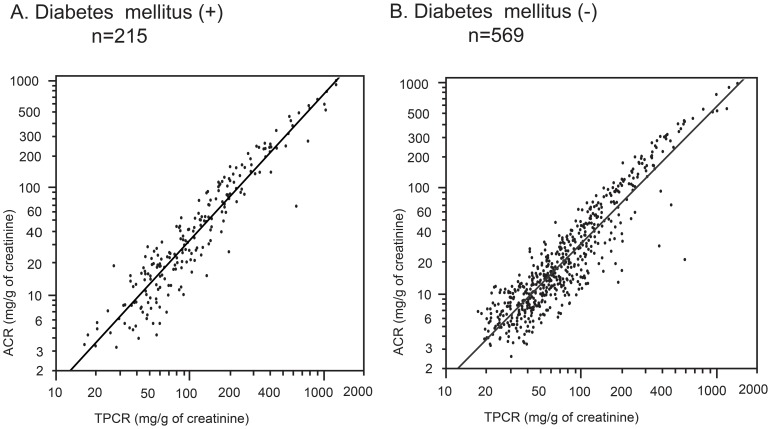
Correlation between the urine albumin-to-creatinine ratio (ACR) and the total urine protein-to-creatinine ratio (TPCR) in the patients with or without diabetes mellitus.All of the axes are on a logarithmic scale.